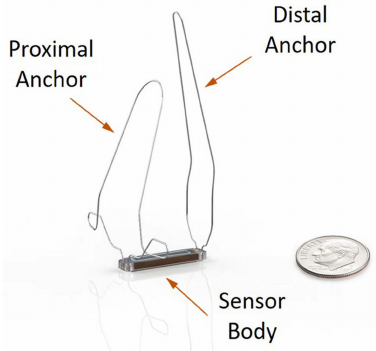
Figure 5. The Cordella HF system pulmonary artery pressure sensor. Reprinted from European Journal of Heart Failure Volume 22, Issue 10, Mullens et al., Effect of pulmonary artery pressure- guided therapy on heart failure readmission in a nationally representative cohort, pages 1912–1919, Creative Commons CC BY license [52].